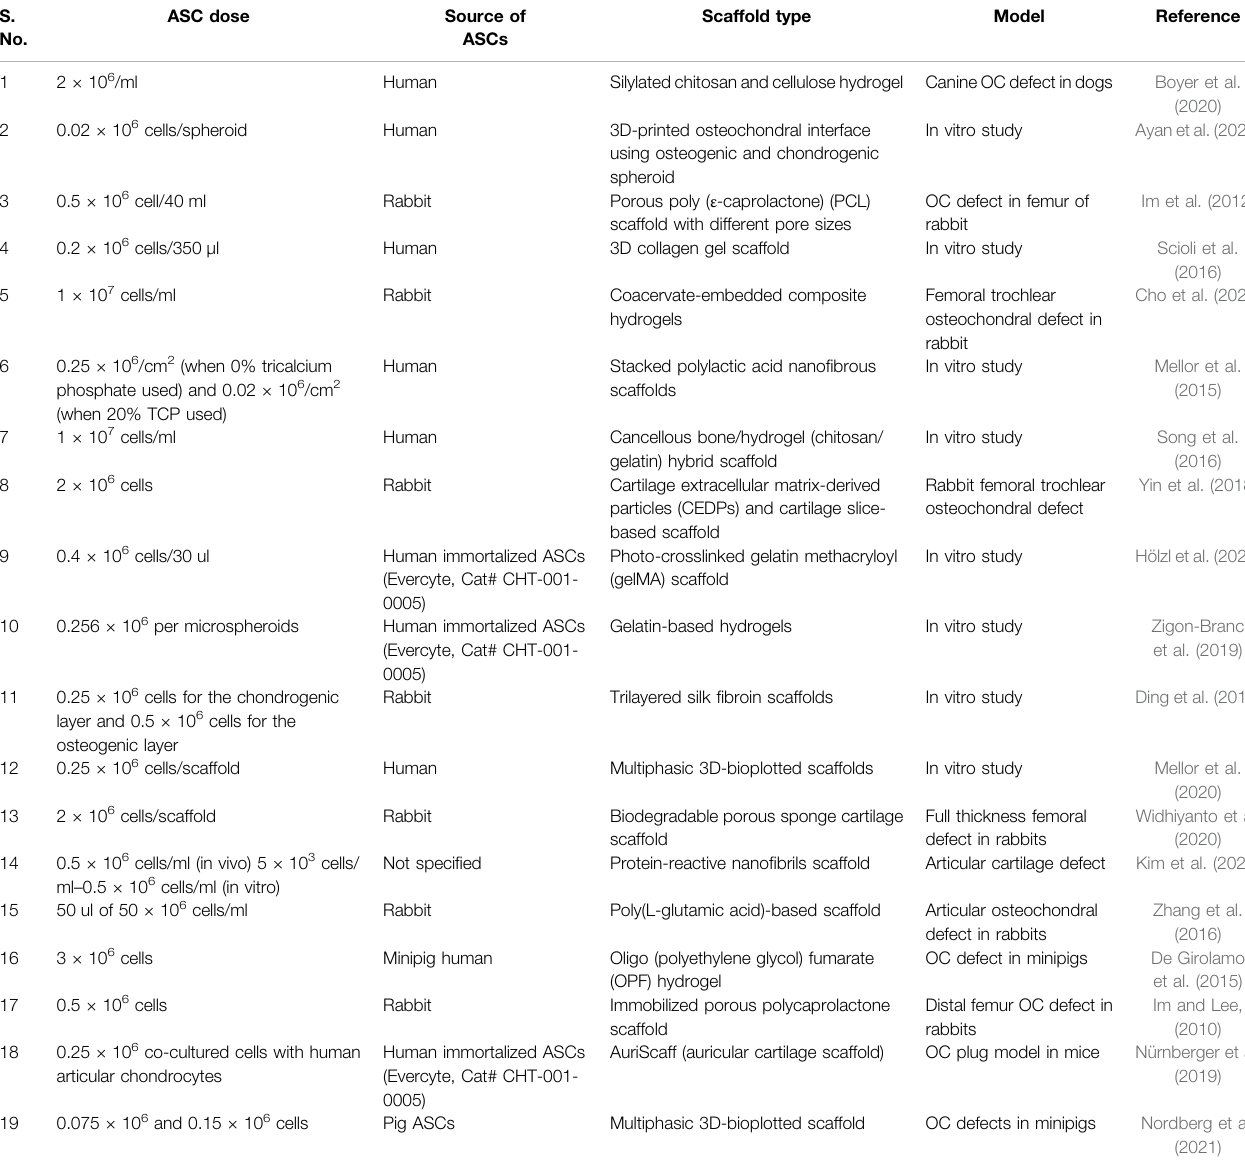
TABLE 1 | In vitro and preclinical application of ASC-scaffold composites. S.